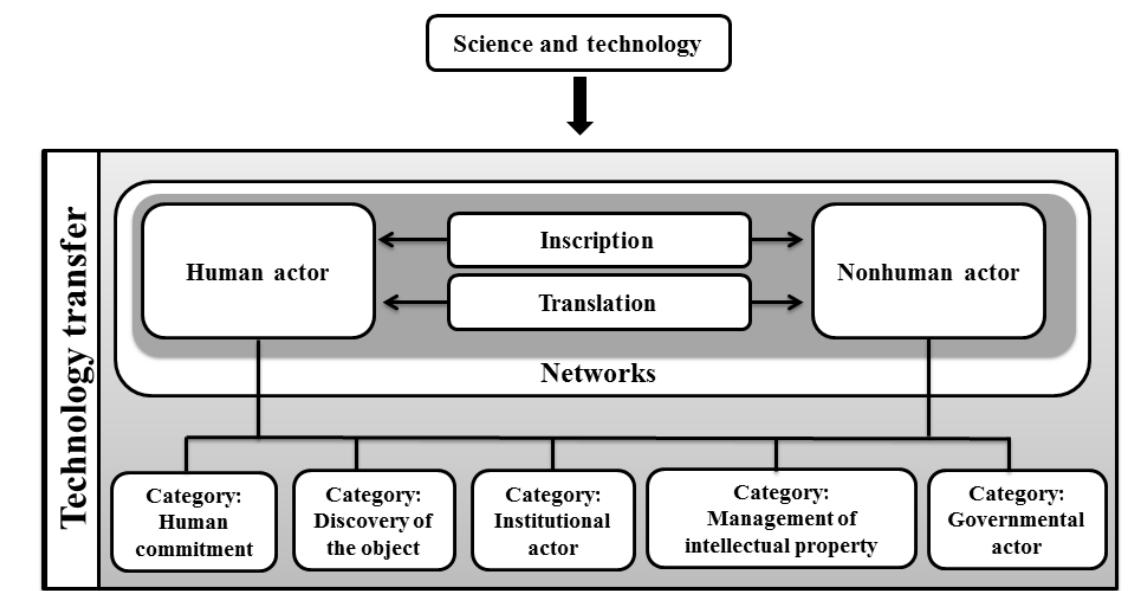
Fig. 1. Analytical